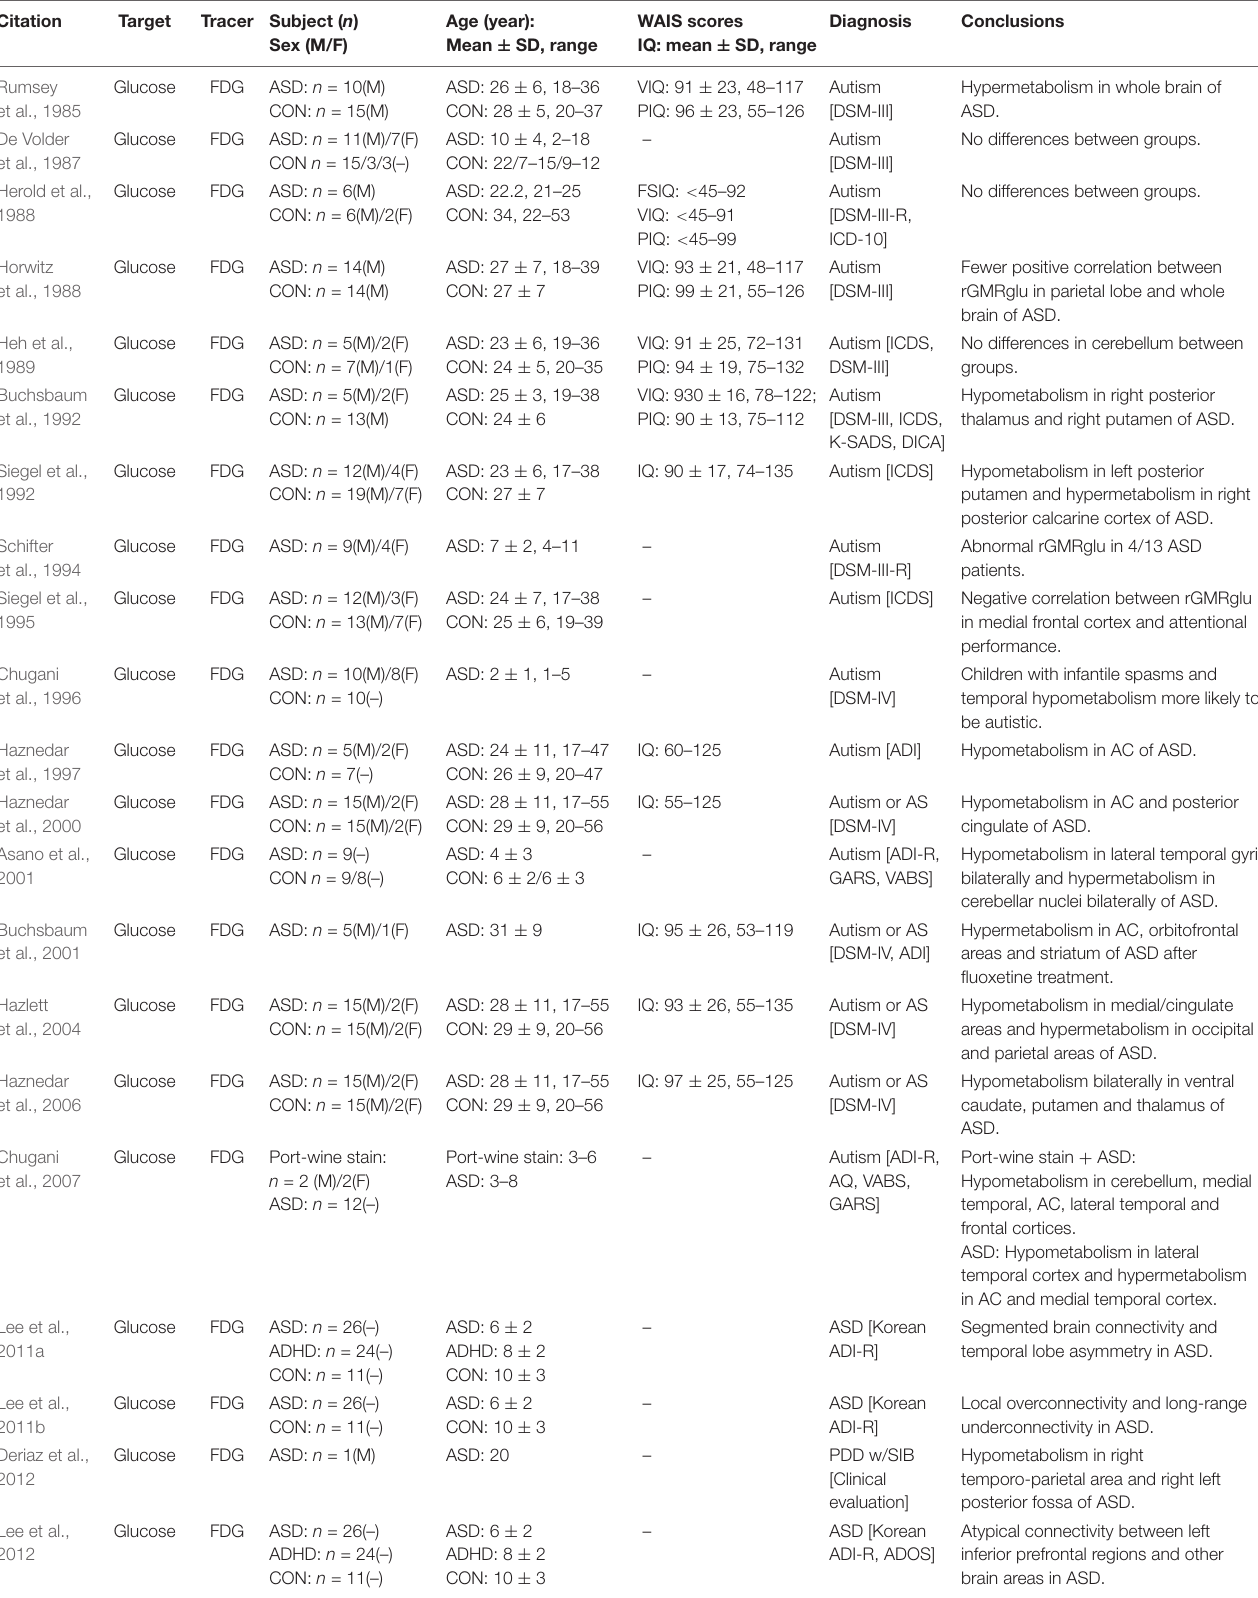
TABLE 2 | FDG PET studies in